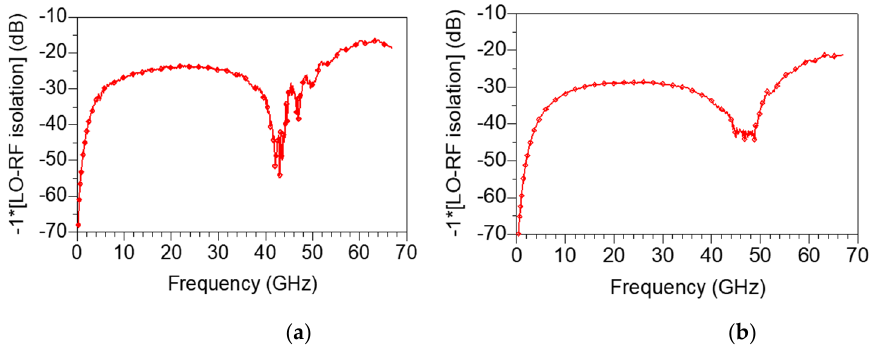
1.5 V, V GG1 = 0.6 V, V GG2 = 0.7 V and V DD = 1.5 V, V GG1 = 0.5 V, V GG2 = 0.5 V, respectively. As